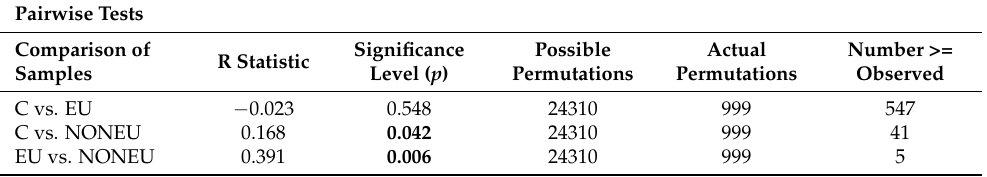
Table 2. One-way analysis of similarity (ANOSIM) between the composite (C), euphotic (EU) and aphotic (NONEU) zone samples in Lake Visovac. Statistically significant values are marked in